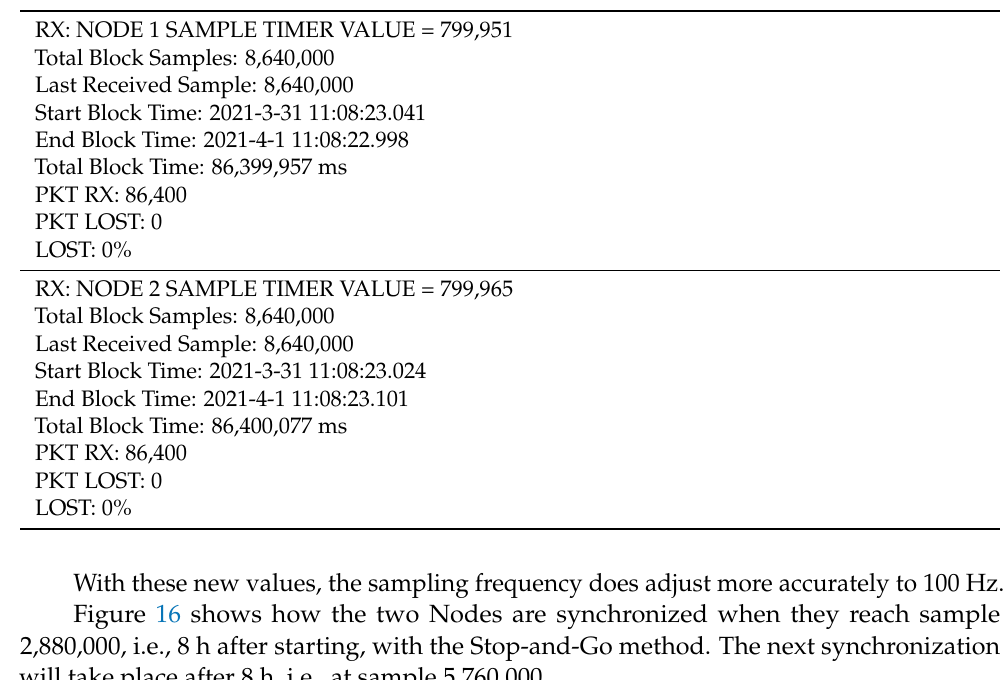
Table 4. Log of Stop-and-Go occurs.